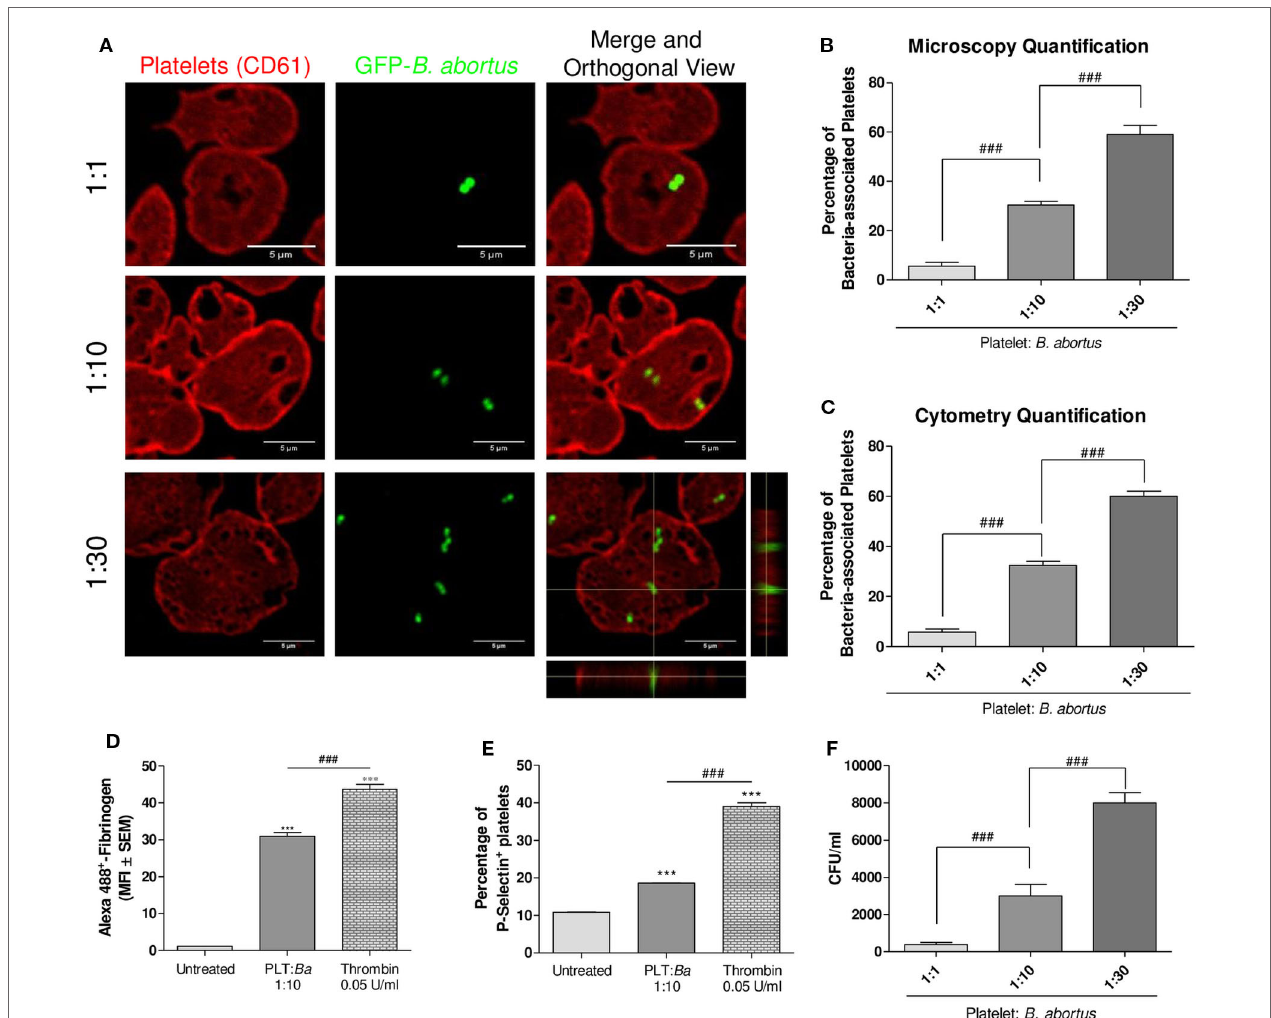
FigUre 1 | There is a direct interaction between platelets and Brucella abortus . (a) Confocal micrographs of platelets incubated with green fluorescence protein (GFP)- B. abortus at different ratios (Platelet:GFP- B. abortus 1:1, 1:10, and 1:30) for 4 h. Platelet population was stained with an anti-human CD61 primary Ab and Alexa 546-labeled secondary Ab (red). (B) Quantification of platelet– B. abortus interaction by confocal microscopy. The number of platelets counted per experimental group was 200. (c) Quantification of platelet– B. abortus interaction by flow cytometry. Data are expressed as the percentage of platelets associated with B. abortus (GFP-positive platelets) ± SEM of three independent experiments. Platelets were also incubated with B. abortus for 30 min and their activation status was measured as Fibrinogen binding (D) and P-selectin expression (e) . The platelet activator thrombin was used as control. Bars represent the arithmetic means ± SEM of three experiments or the percentage of platelets that express P-selectin. MFI, mean fluorescence intensity. (F) Quantification of platelet invasion by B. abortus . Data are expressed as colony-forming units (CFU) per ml. *** P < 0.001 vs. untreated; ### P <